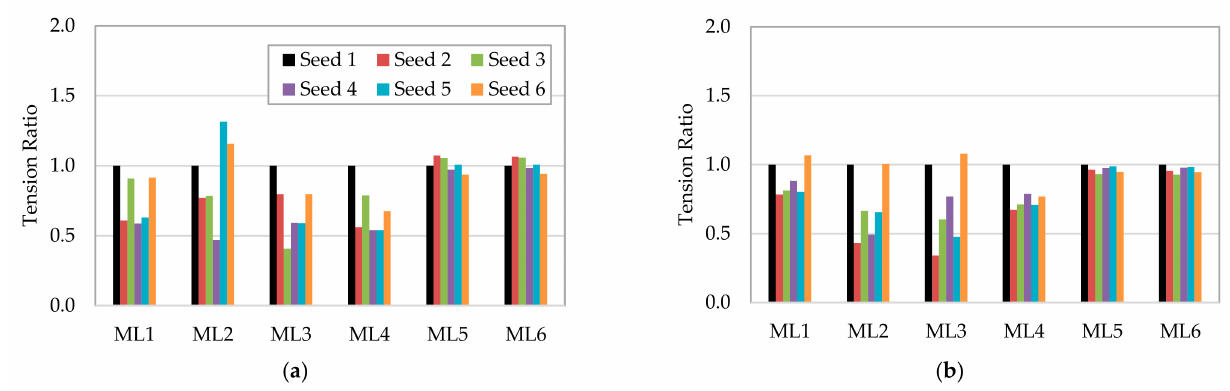
Figure 15. Buoy mooring line tension variations due to change of wave seeds for coupled case and heading 0 deg.: ( a ) 50 y; ( b ) 100